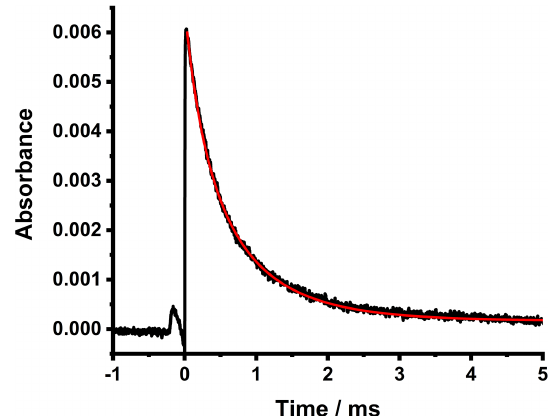
Figure 4. Normalised CH 2 OO spectrum obtained in this work (black) and that reported previously (Chang et al., 2018a) (multi- plied by − 1) (red). Measurements made in this work were obtained at a total pressure of 50Torr at 298K in the absence of SO 2 , with [CH 2 I 2 ] ∼ 2 × 10 14 cm − 3 and a laser fluence of 30mJcm − 2 . The data shown are the means of 1000 photolysis shots at each current setting on the QCL with the wavenumber calibrated using the re- sults reported in previous work (Chang et al., 2018a). The inset plot shows the normalised spectra obtained in this work (black) and by Chang et al. (2018a) (red) on the same scale. The experiments and the HITRAN database indicate that there is no appreciable absorp- tion by CH 2 I 2 in this region of the spectrum.